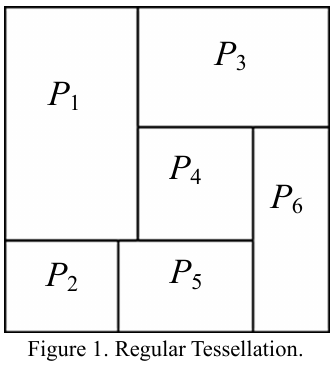
Figure 1. Regular